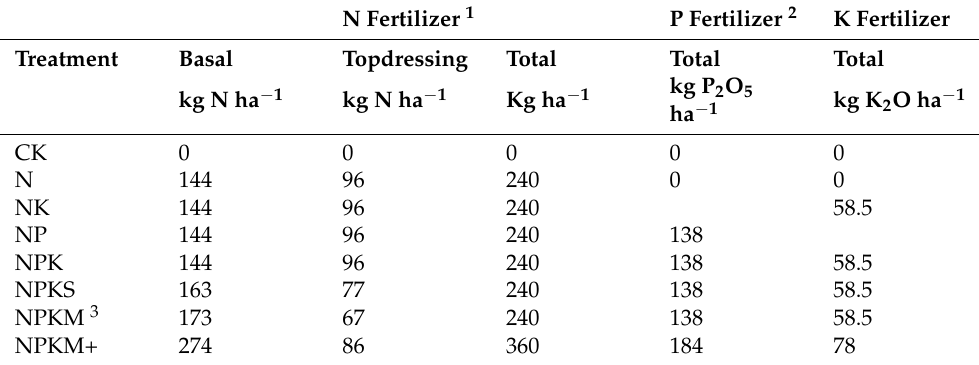
Table 2. Quantity of fertilizers from the different fertilizer treatments in the long-term experiment in a gray desert soil.